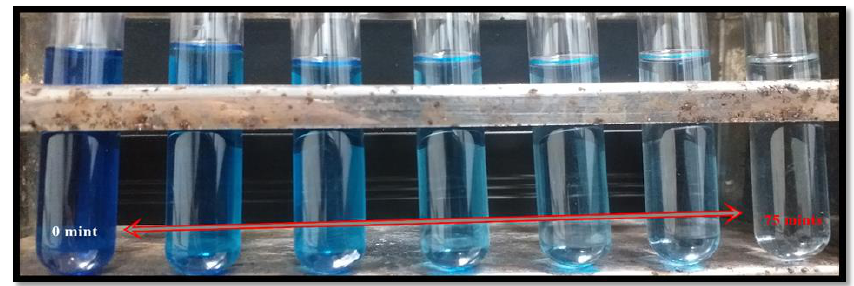
Figure 11. Dye decolorization within 75 min after exposure to visible light.